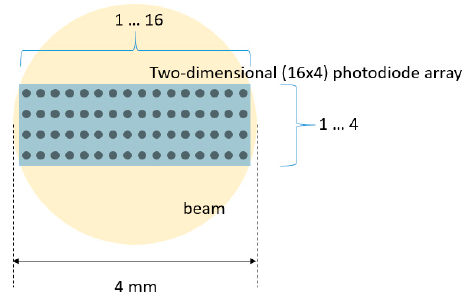
Figure 4. Beam footprint on the two-dimensional PD array.